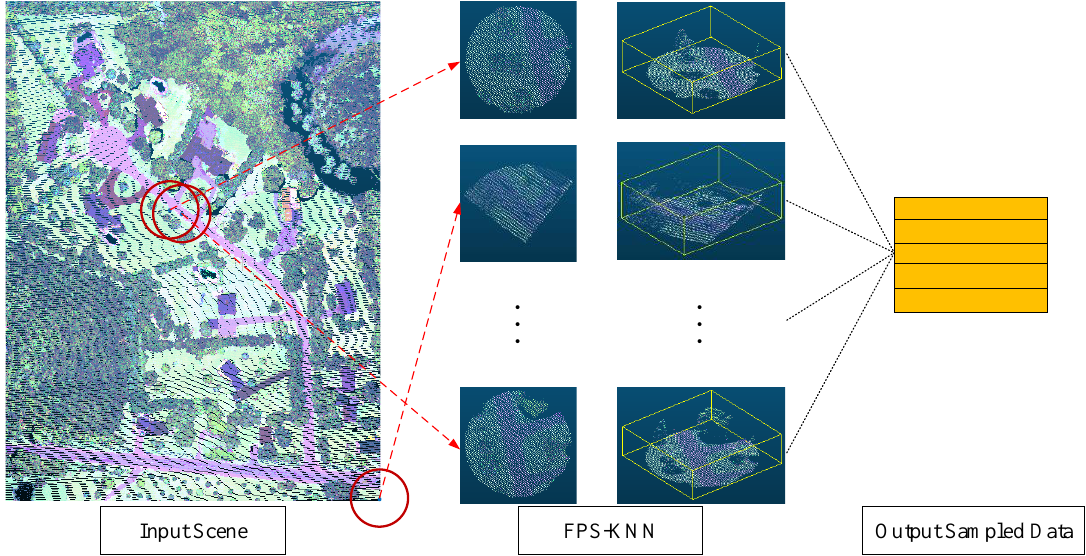
Figure 4. Sample generation workflow with the FPS-KNN method.